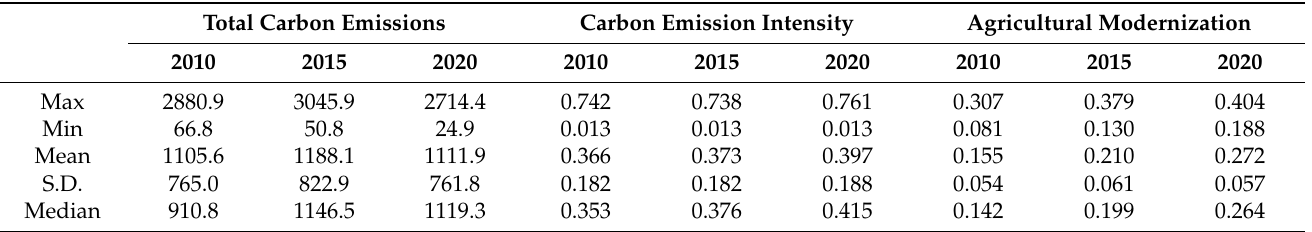
Table 4. Descriptive statistics on agricultural carbon emissions and the level of agricultural modern- ization in 30 provinces.